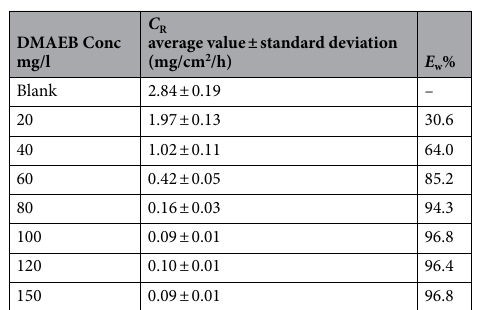
C R average value ± standard deviation (mg/cm 2